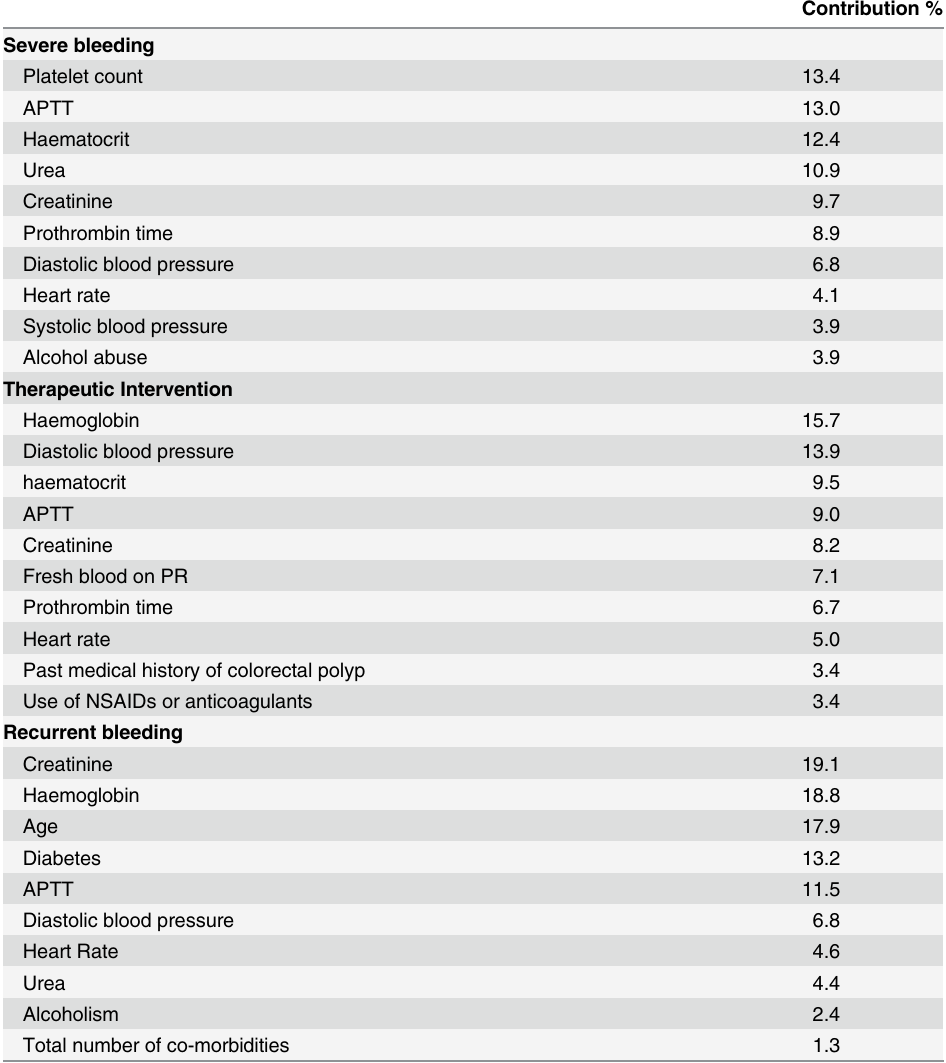
Table 5. Top ten variable importance using gradient boosting